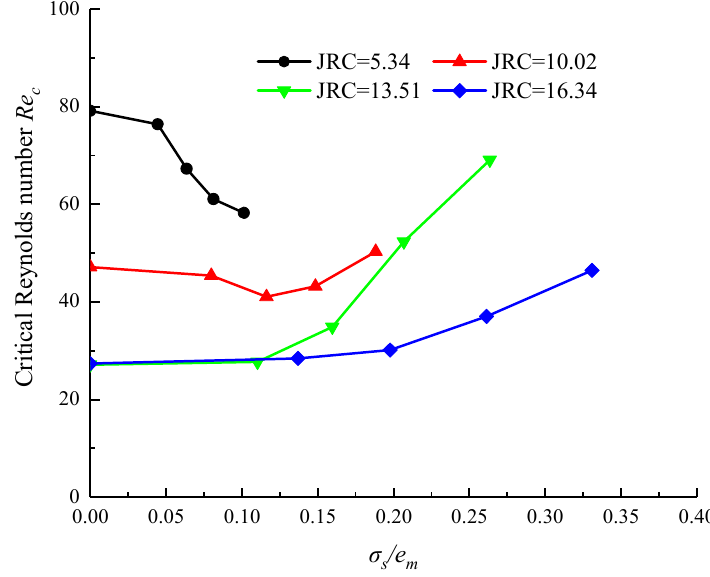
Figure 14. Relationship between critical Reynolds numbers Re c and σ s / e m with di ff erent